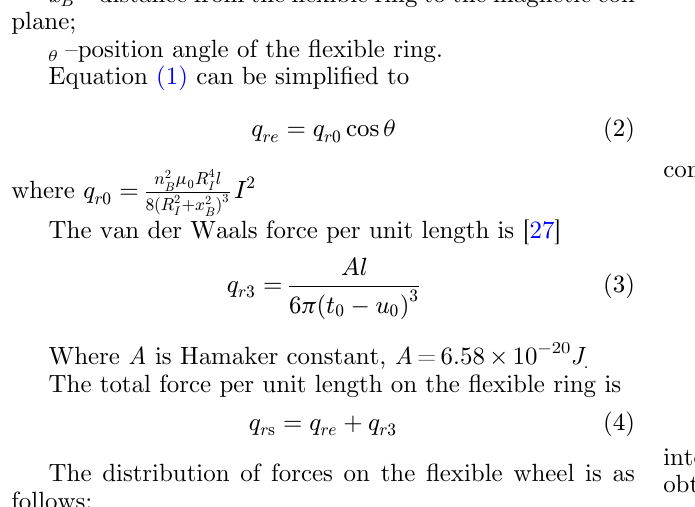
x (cid:1) distance from the fl exible ring to the magnetic coil B plane; – position angle of the fl exible u